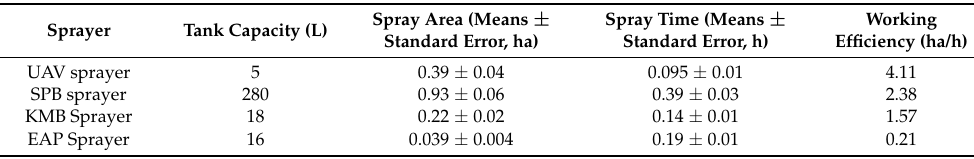
Table 2. Working efficiency (ha/h) of four